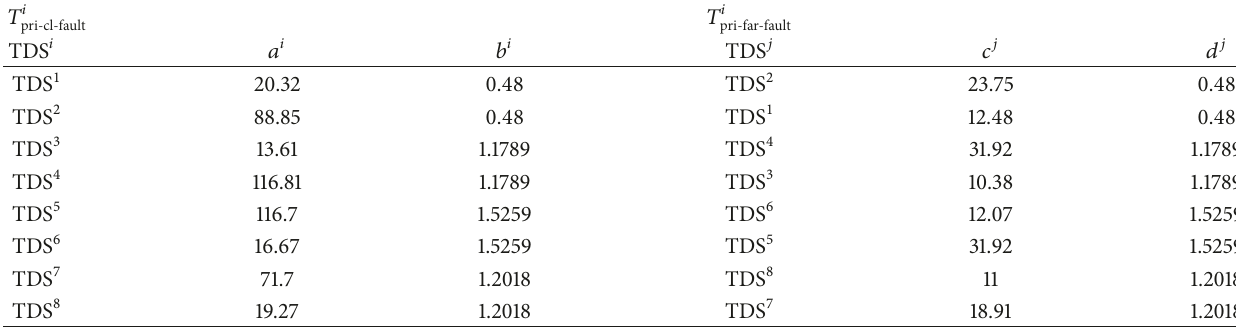
Table 9: Values of constants 𝑎 𝑖 ,𝑏 𝑖 ,𝑐 𝑖 , and 𝑑 𝑖 for Model